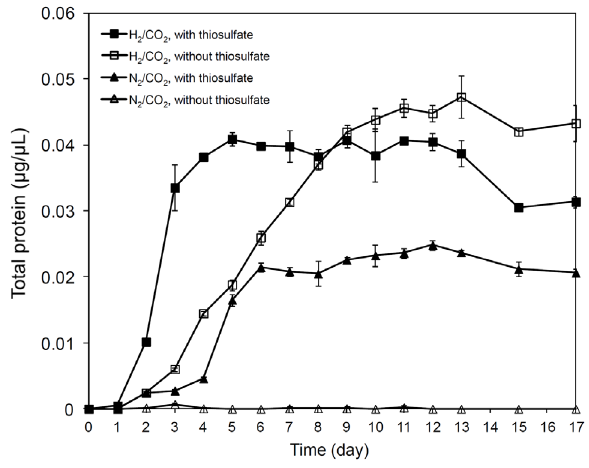
Figure 1. Growth of S.denitrificans DSM-1251 under different cultivation conditions. S. denitrificans DSM-1251 cells were grown in DSMZ medium 113 containing thiosulfate (18.8 mM, filled marker) or without thiosulfate (open marker). The headspace was completely exchanged with H 2 /CO 2 (80%/20%) (square) or with N 2 /CO 2 (80%/20%) (triangle). Error bars indicate the standard deviations from measure-